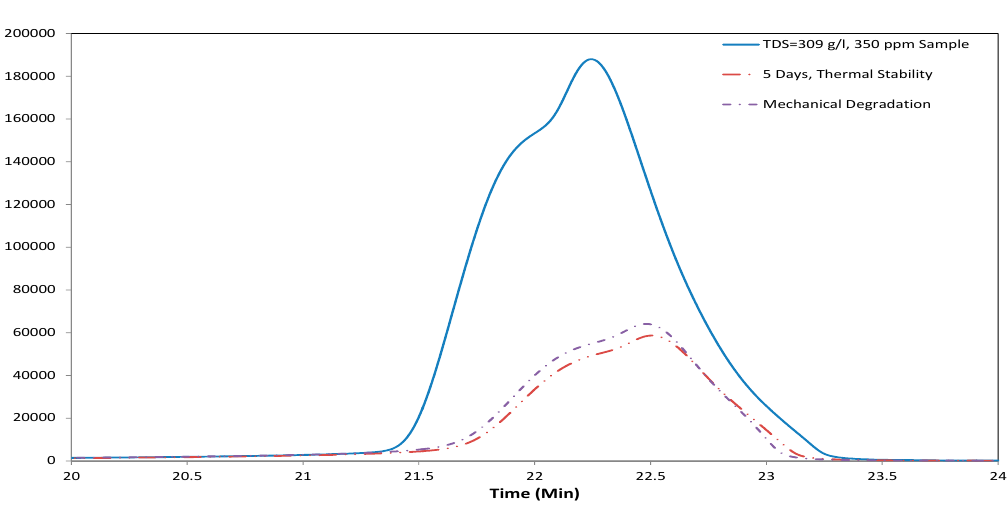
Figure 10. Molecular weight distribution of the biopolymer solutions made with the 309 g/L brine (extreme conditions).